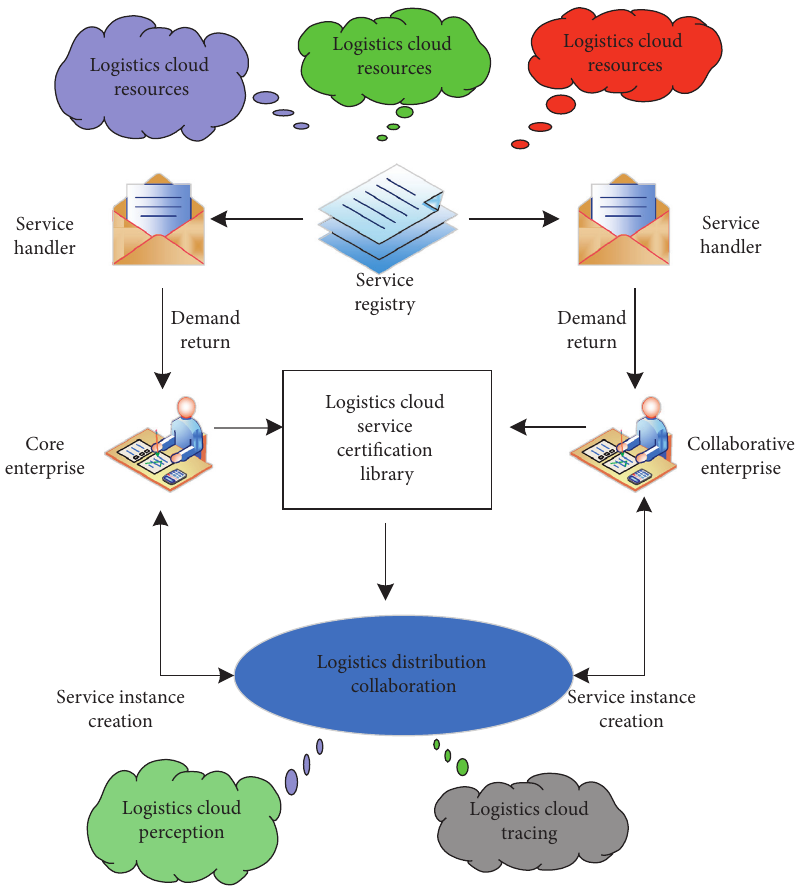
Figure 5: Cloud service process of regional logistics